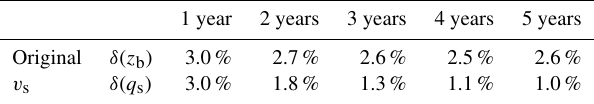
Table 4. Quantification of the difference between predictions of the flux form and the entrainment form in the case of uniform sediment. The maximum δ values in the calculational domain are presented for 5 years.